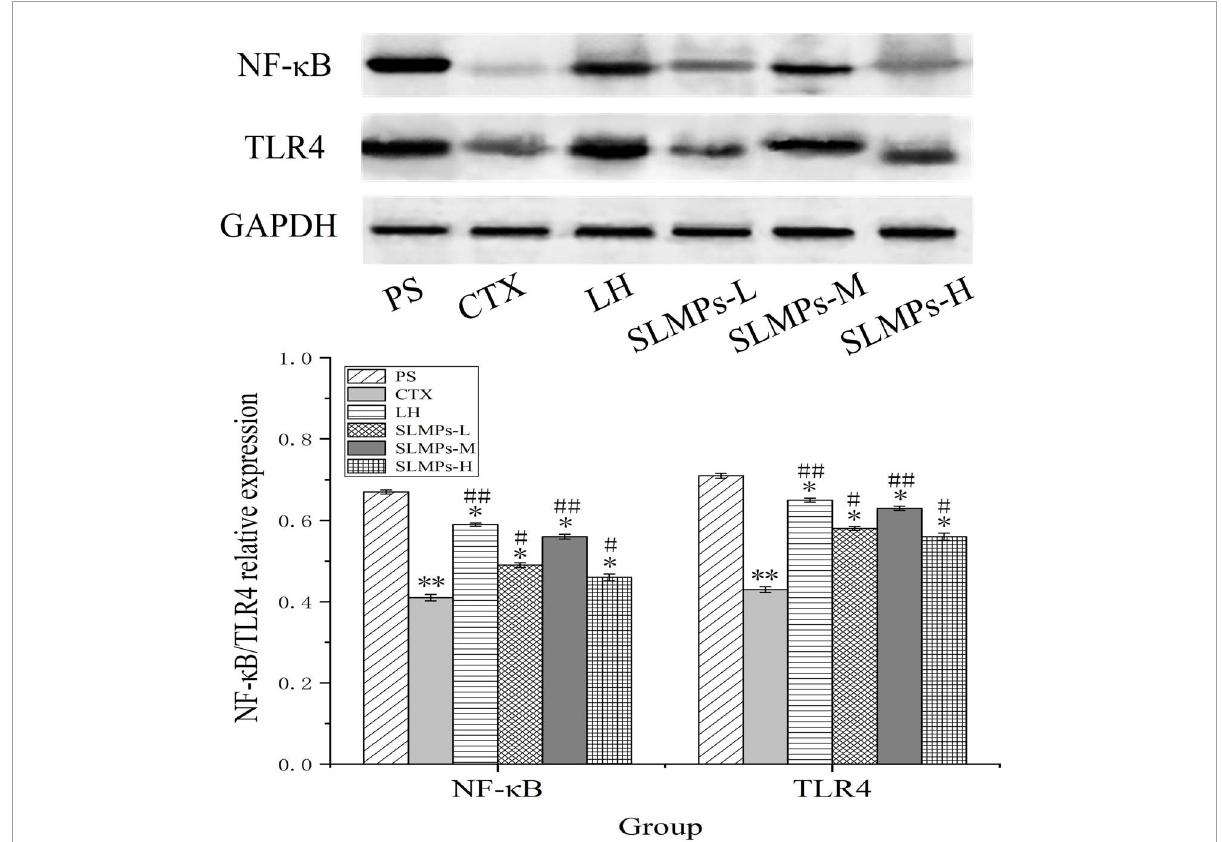
FIGURE11 Effects of SLMPs-1-1 on the proteins expression of NF- κ B and TLR4 in spleen [compared with PS group ( ∗ P < 0.05; ∗∗ P < 0.01); compared with CTX group ( # P < 0.05; ## P <